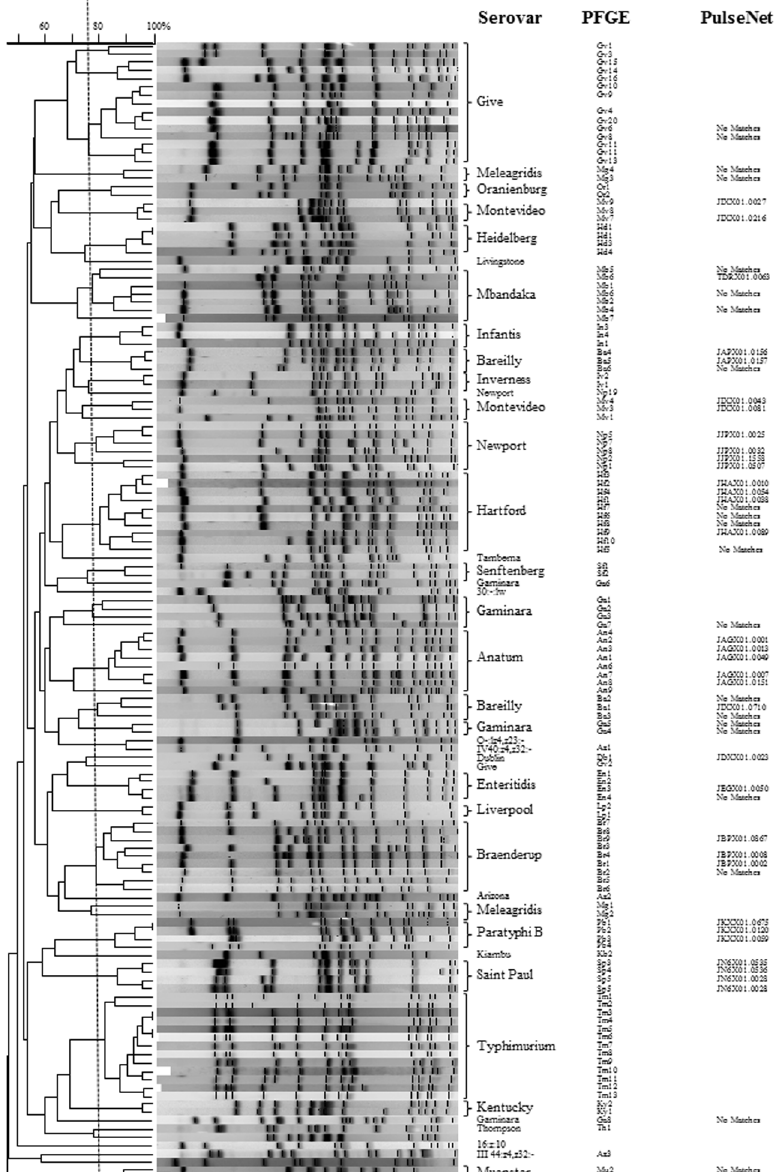
Fig 2. Dendrogram of representative Salmonella PFGE patterns for 37 Salmonella serovars (excluding S . enterica serovars Muenchen and Rubislaw) collected from Oconee and Little River watersheds and archived isolates with similar PFGE profiles. Salmonella PFGE patterns generated in this study were compared to a BioNumerics database of PFGE entries of Salmonella isolates from various animal species and to the CDC PulseNet data base of isolates from human cases. Vertical line indicates 75% similarity.